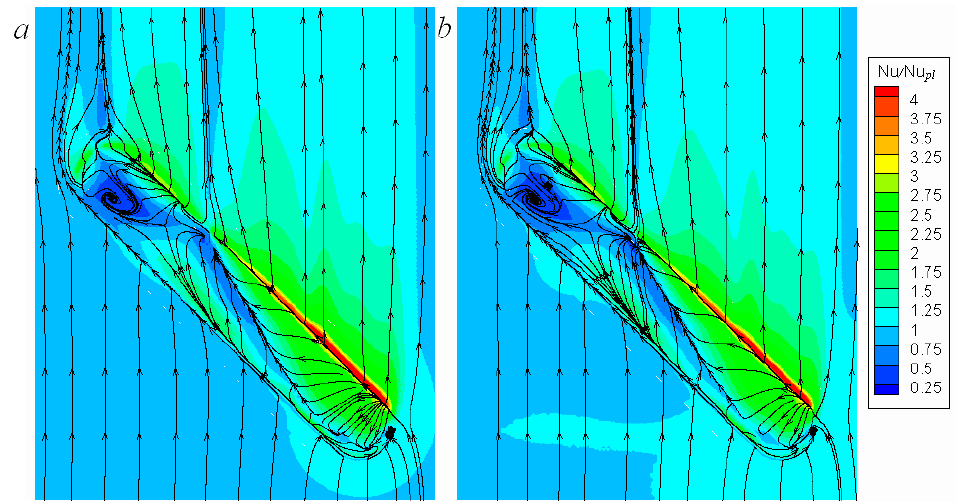
Figure 9. Relative Nusselt number distributions in the section of the narrow channel with the oval dimple of width 0.383 calculated on different grids: ( a )—initial variant (about 1.6 mln cells); ( b )— refinement (about 3 mln cells).